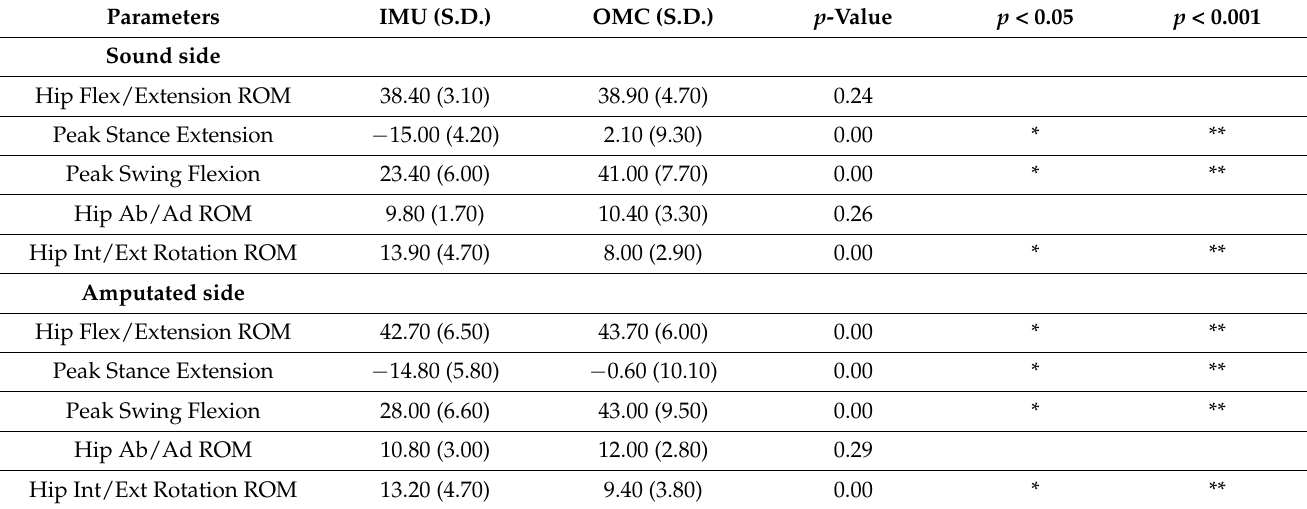
Table 4. Hip joint angle parameters of thirty participants on sound and amputated side as mean (S.D.) over five gait cycles calculated by the IMU and OMC.